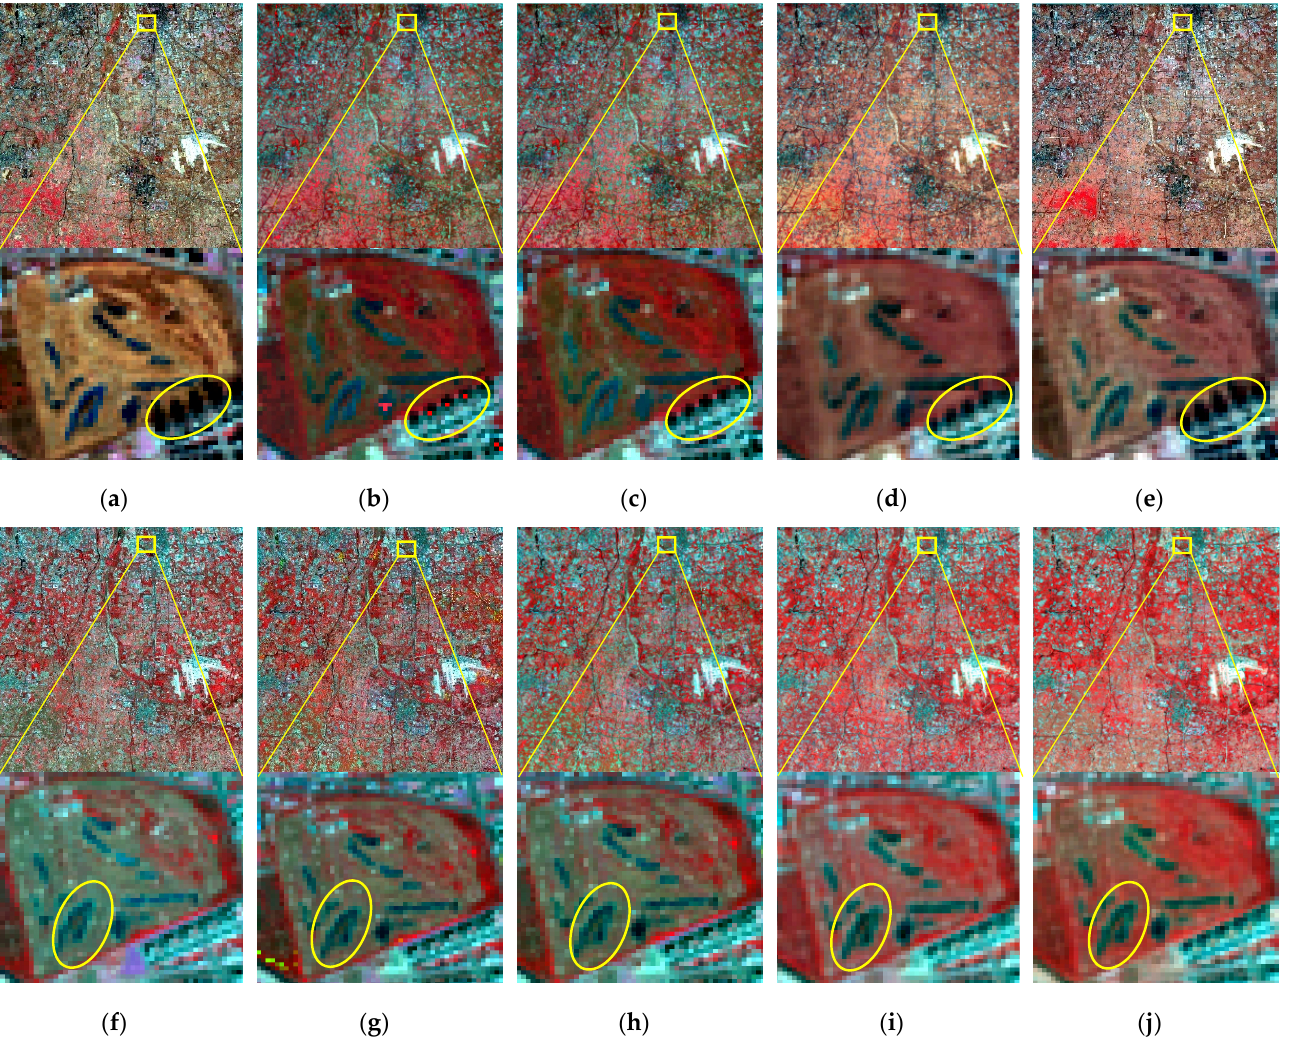
Figure 15. Experimental results based on the Daxing dataset for spatiotemporal fusion: ( a , f ) Ground